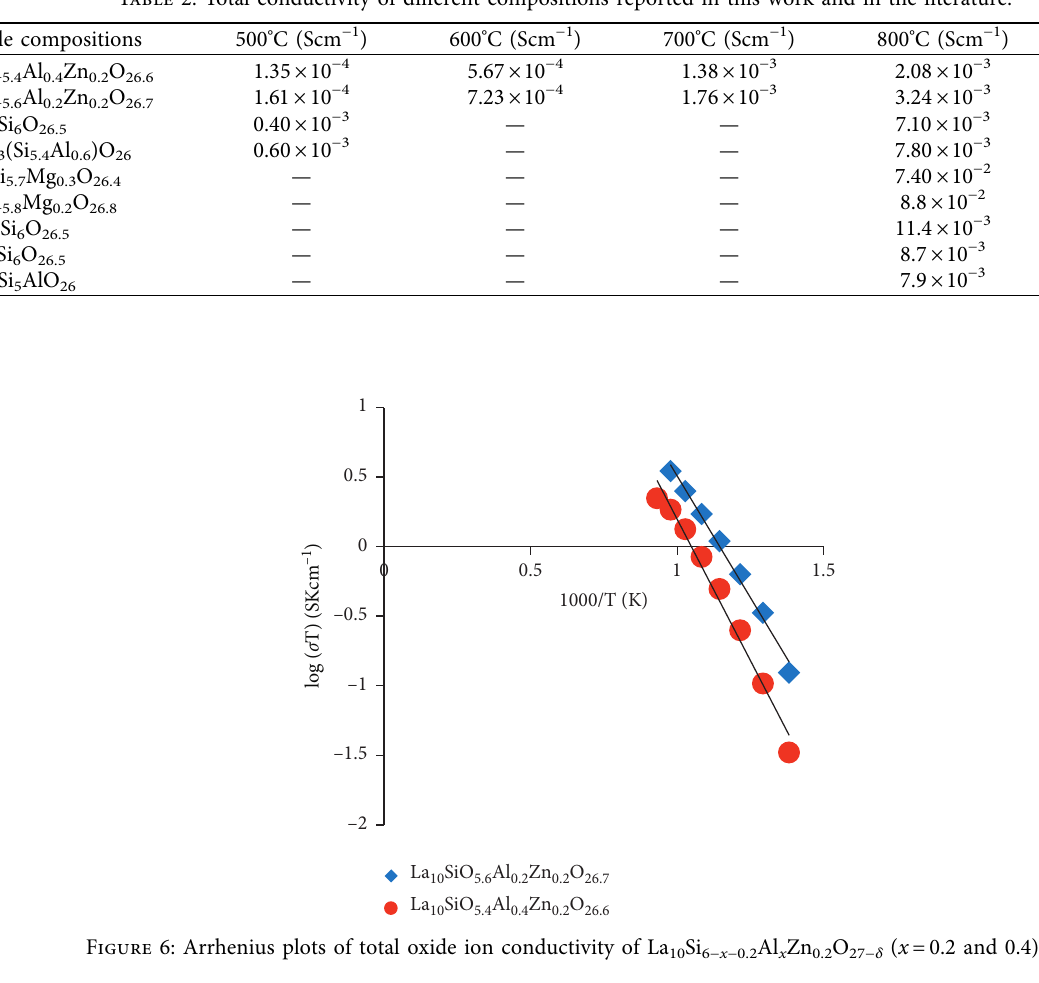
� 0.2 and 10 Si 6 − x − 0.2 Al x Zn 0.2 O 27 − δ ( x